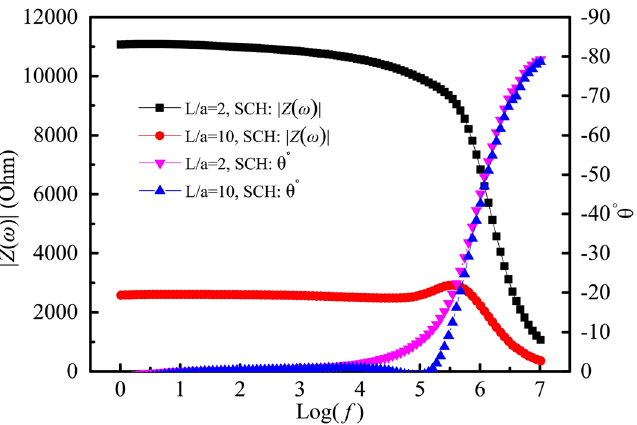
Figure 10. Bode plots of oven-dried samples evaluated by four-point